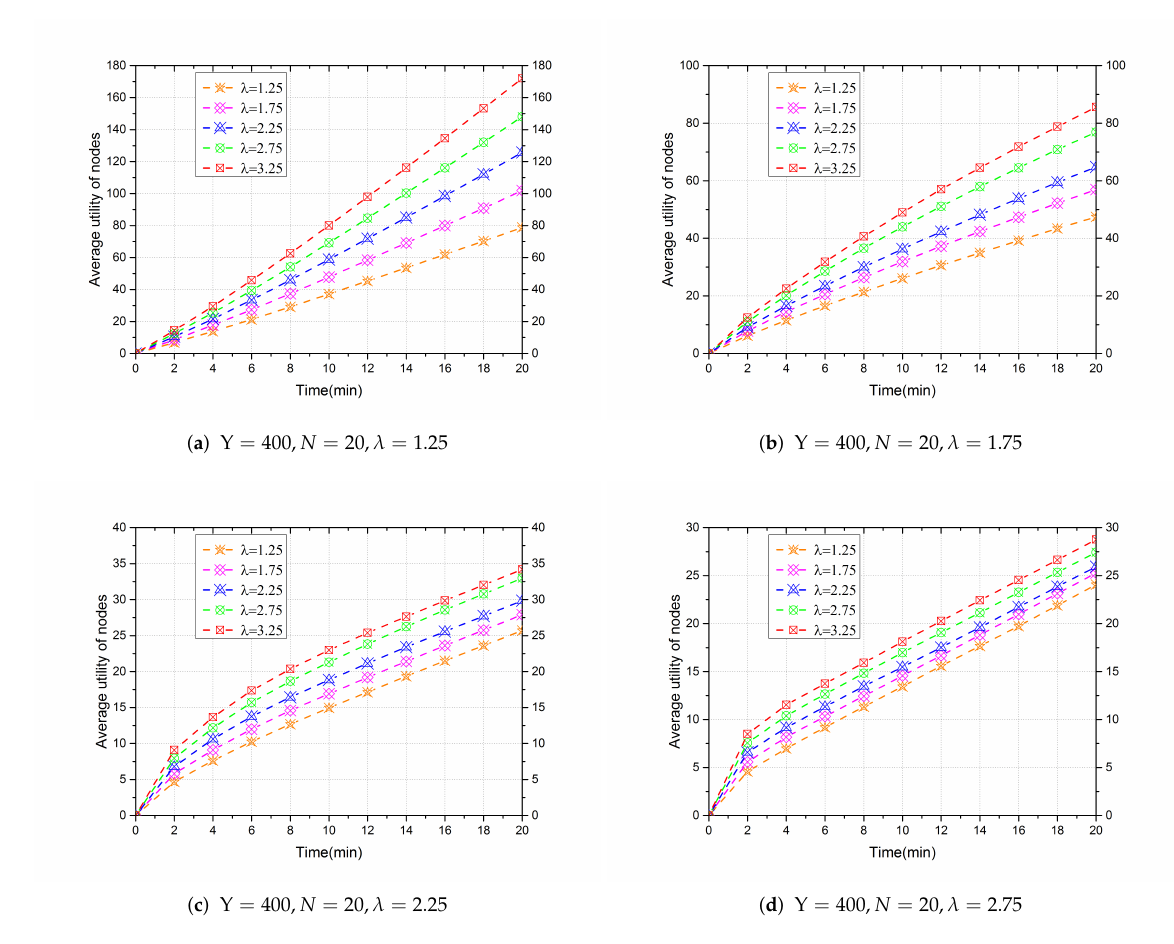
Figure 4. The influence of the λ value on the average node